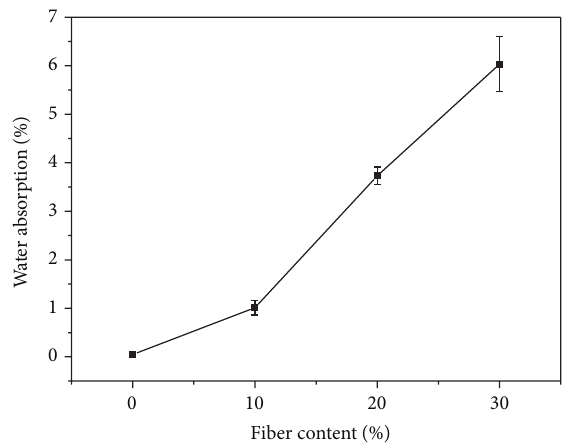
Figure 8: Water absorption by immersion of composite materials reinforced with fique fibers at 23 ∘ C.